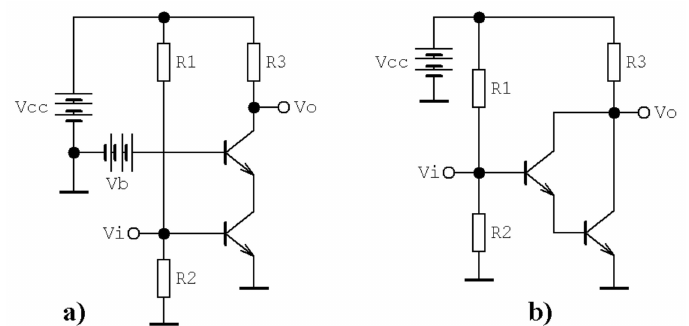
Figure A1. Traditional topology of analyzed amplifiers, circuit is driven by the input voltage Vi while the response can be obtained at node Vo: ( a ) cascoded type, ( b ) having Darlington’s